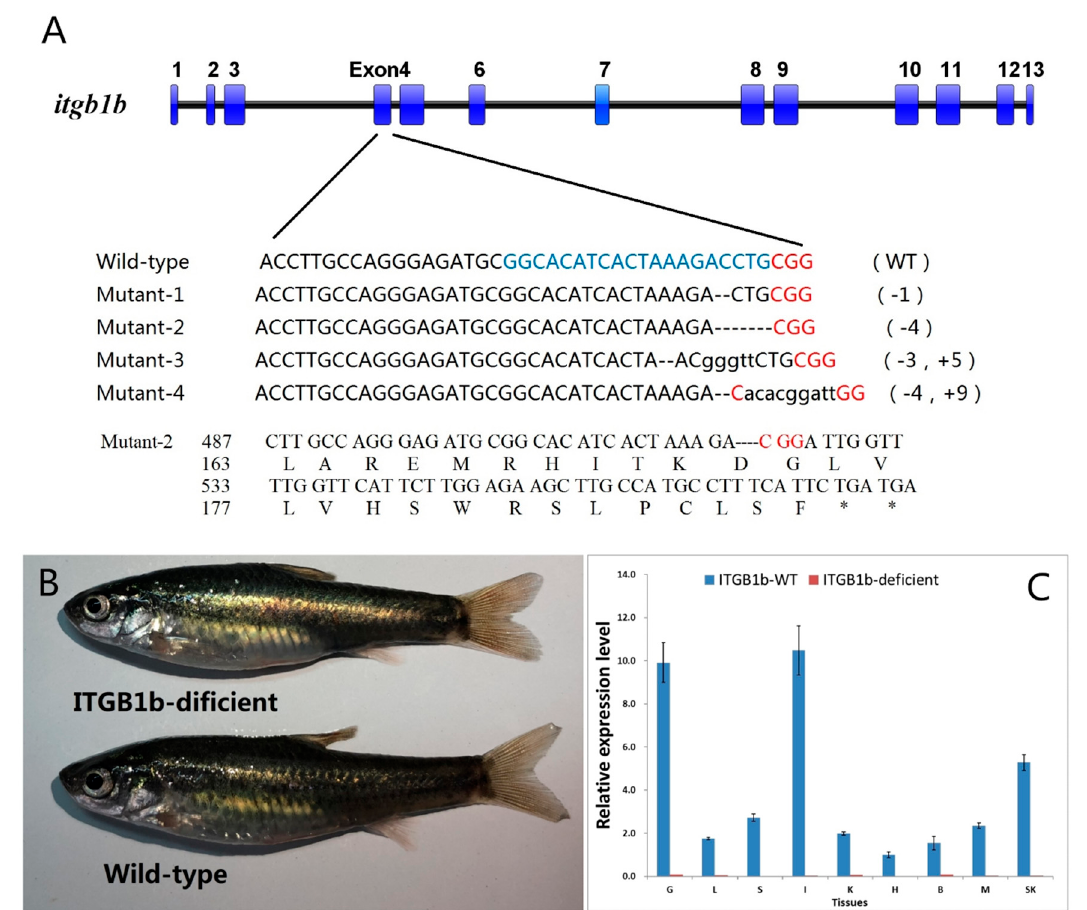
Figure 2. Mutations induced by the CRISPR/Cas9 system in the target sequence. ( A ) The thick, thin blue strips in the top shown as exons. Numbers to the right indicated the loss or insertion of bases for each allele. Deletions are shown as black dotted line and insertions as lower-case letters. The wild-type sequence is presented at the top, with the target site highlighted in blue and the PAM(protospacer adjacent motif) sequence highlighted as red. ( B ) Wild-type and ITGB1b-deficient rare minnows at 4-month-old. ( C ) Confirmation of loss of itgb1b expression level by RT-qPCR. β -actin was used as an internal control. The relative expression level was presented as the ratio of gene expression level in different tissues relative to that in the heart tissue from the wild-type fish. G, Gill; L, Liver; S, Spleen; I, Intestine; K, Kidney; H, Heart; B, Brain; M, Muscle; SK, Skin.